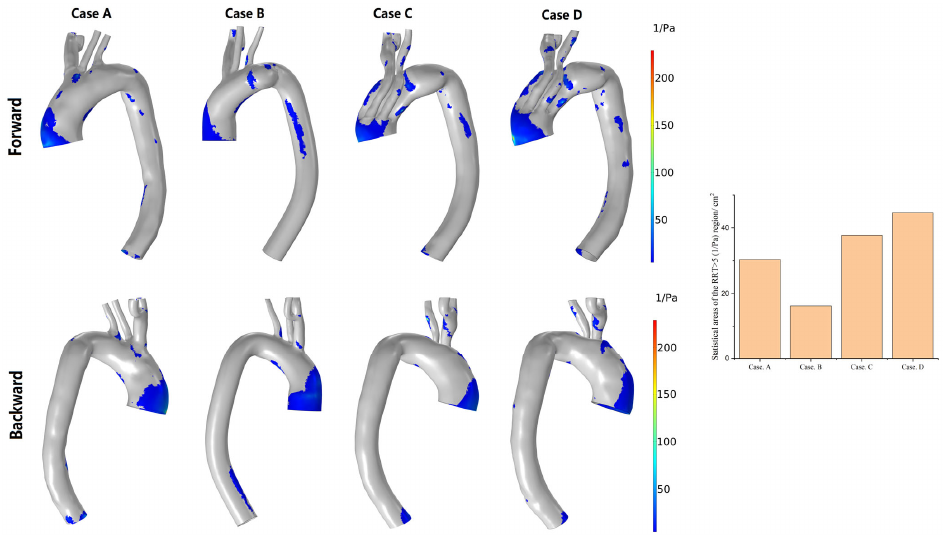
Figure 10. Changes in the regional distribution of the RRT of 5 Pa − 1 and the area statistics of the four models. (Case A ) Normal model; (Case B ) Preoperative model; (Case C ) 1-week postoperative model; (Case D ) 6-week postoperative model.